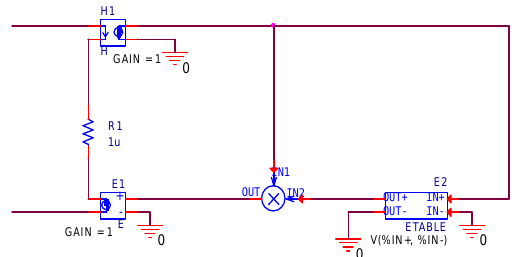
Figure 23: Dynamic resistor model general structure This model then allows to consider the snapback effect.